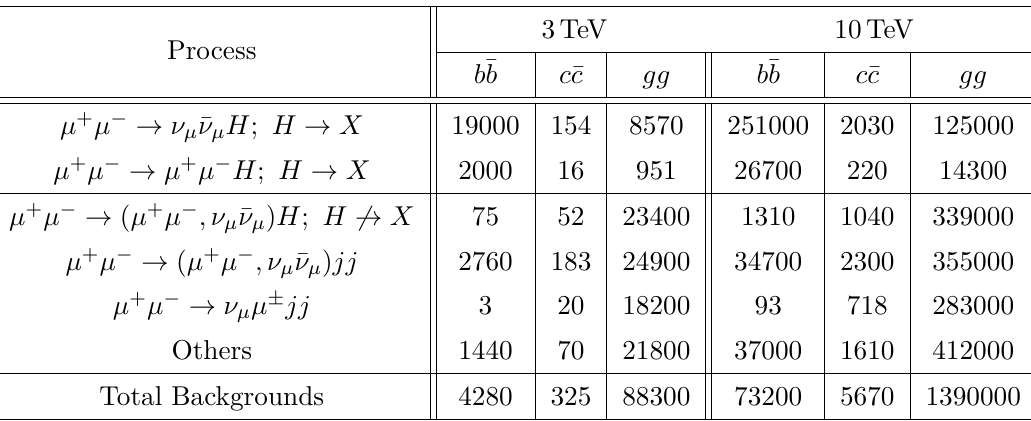
Table 1 . Signal and some of the most important backgrounds for VBF H → X , with X one of ( b ¯ b, c ¯ c, gg ) , after applying flavor tagging and analysis cuts. “Others” consists of s -channel and VBF diboson production, tb , and t ¯ t